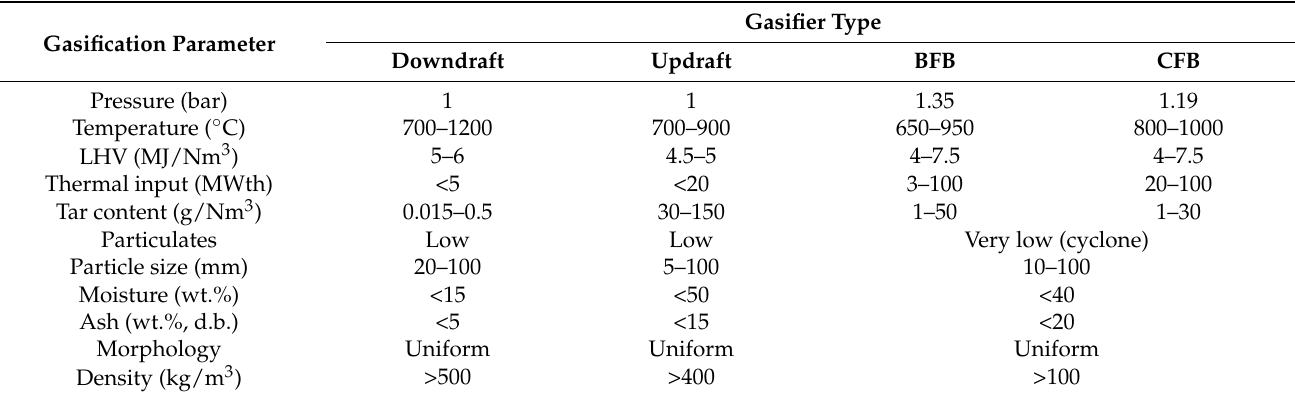
Table 2. General characteristics of conventional air gasification